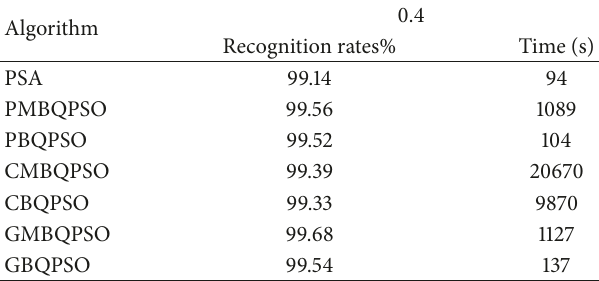
Table 7: Salinas subpixel mapping